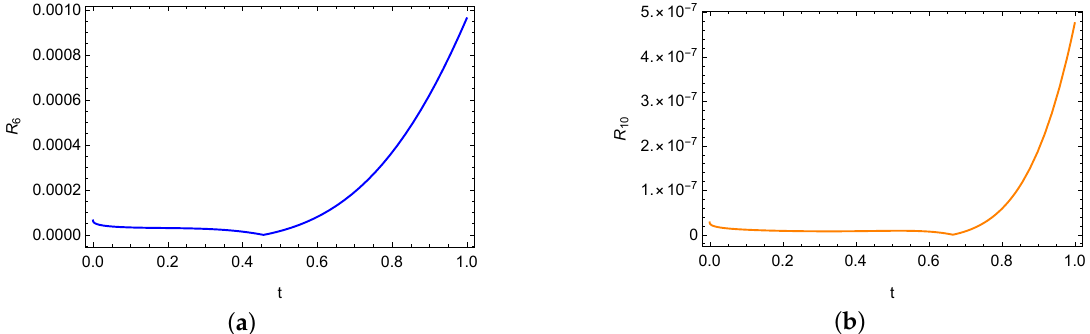
Figure 6. Functions R i without a logarithmic scale: ( a ) function R 6 , ( b ) function R 10